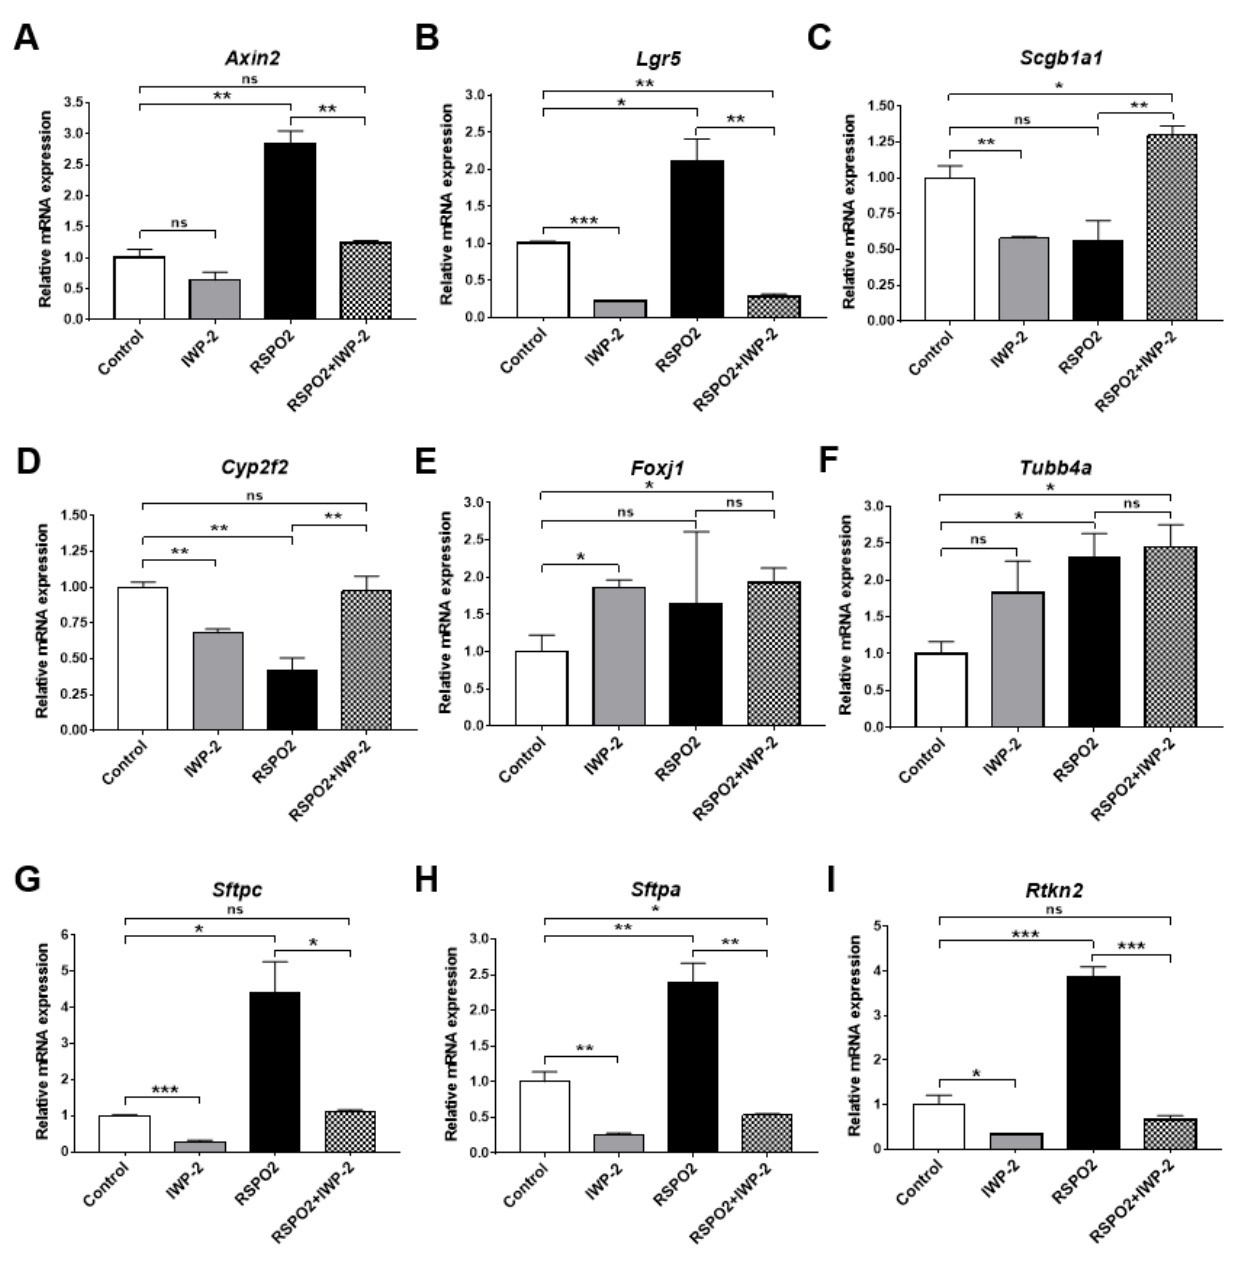
Figure 5. RSPO2 drives the differentiation of club cells into alveolar lineages in an endogenous WNT/ β -catenin activation-dependent manner. ( A , B ) qRT-PCR analysis of WNT/ β -catenin down- stream target genes, Axin2 and Lgr5 , in IWP-2 (5 µ M)- and/or RSPO2 (200 ng/mL)-treated club cell-derived organoids. ( C – I ) qRT-PCR analysis of club cell markers Scgb1a1 ( C ) and Cyp2f2 ( D ), ciliated cell markers Foxj1 ( E ) and Tubb4a ( F ), AT2 cell markers Sftpc ( G ) and Sftpa ( H ), and AT1 cell marker Rtkn2 ( I ) in the club cell organoids treated with IWP-2, RSPO2, or both. All organoids were collected for RNA isolation at day 14 of culture. Data are presented as mean ± SEM. ns: no statistical significance, * p < 0.05, ** p < 0.01, *** p <